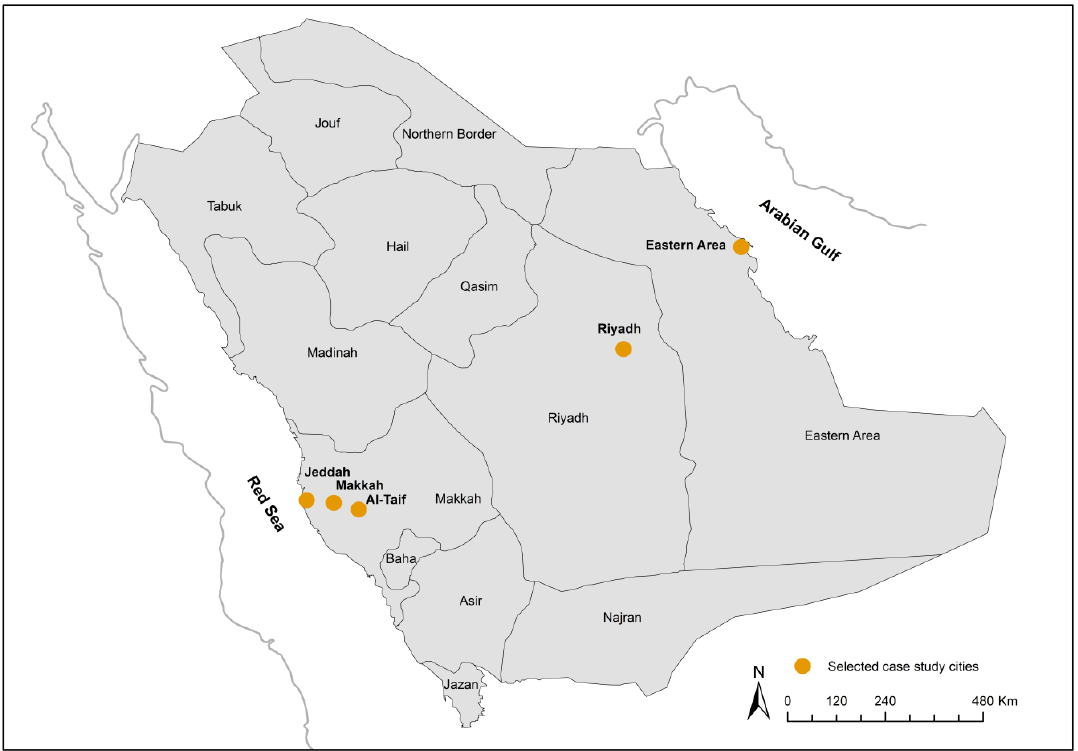
Figure 1. Geographical locations of the selected cities in Saudi Arabia